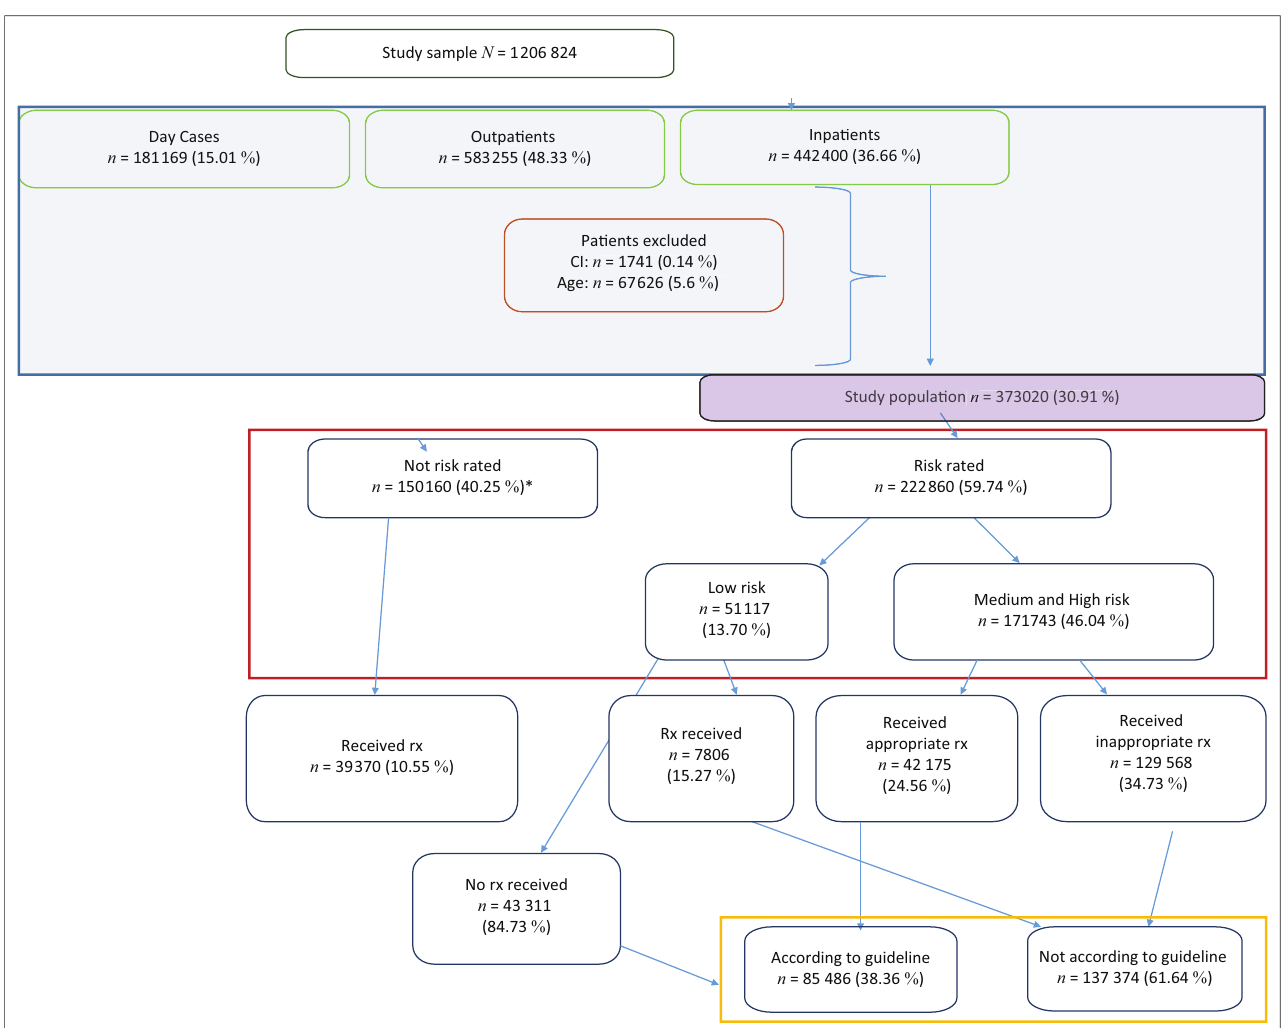
FIGURE 1: Data for study